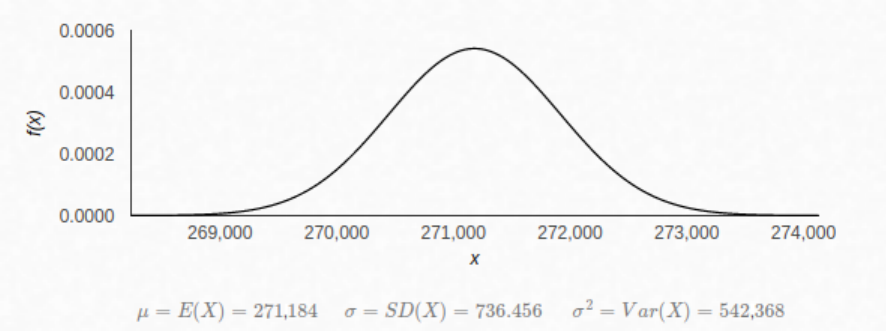
Figure 6. Chi-square Distribution Plot Proving Null